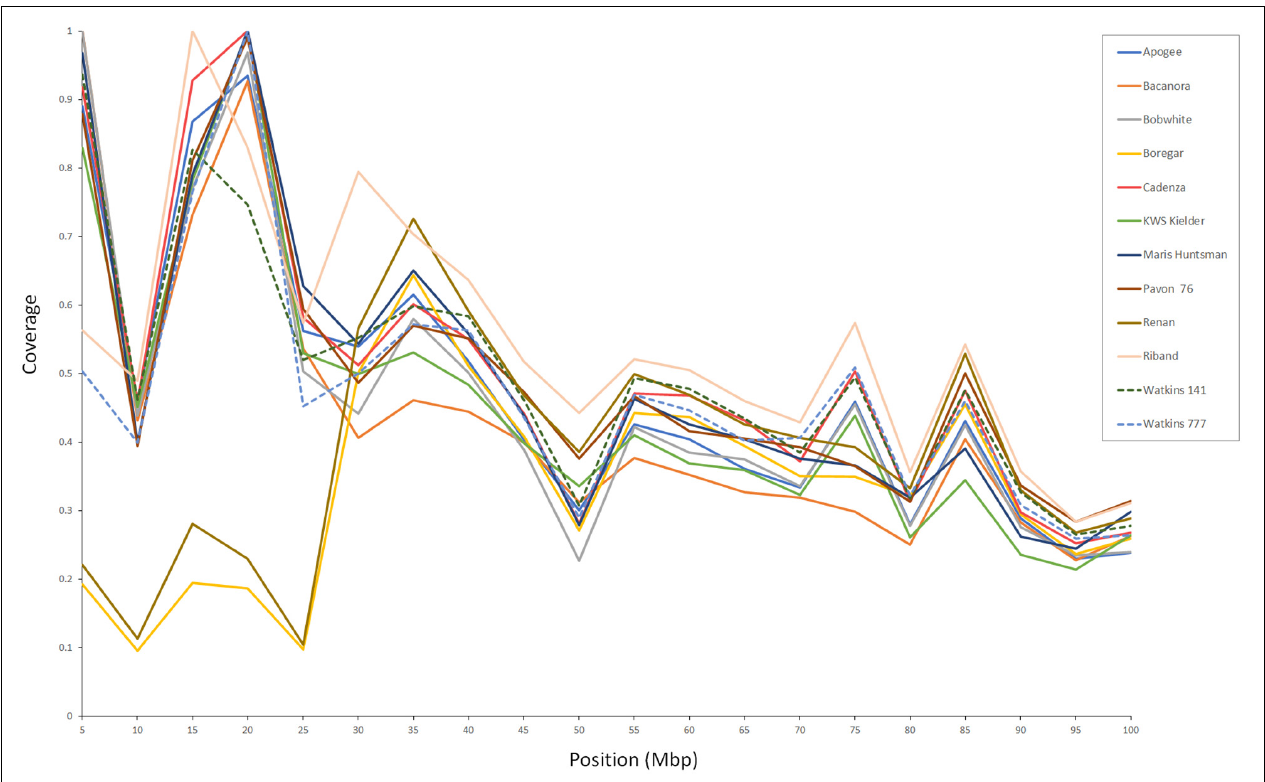
FIGURE 3 | Sequence coverage across the first 100 Mb of chromosome 2AS. The two accessions, ‘Boregar’ and ‘Renan’, show reduced coverage across the first 25–30 Mb which corresponds with the size of the known introgression from Ae. ventricosa (Robert et al., 1999).